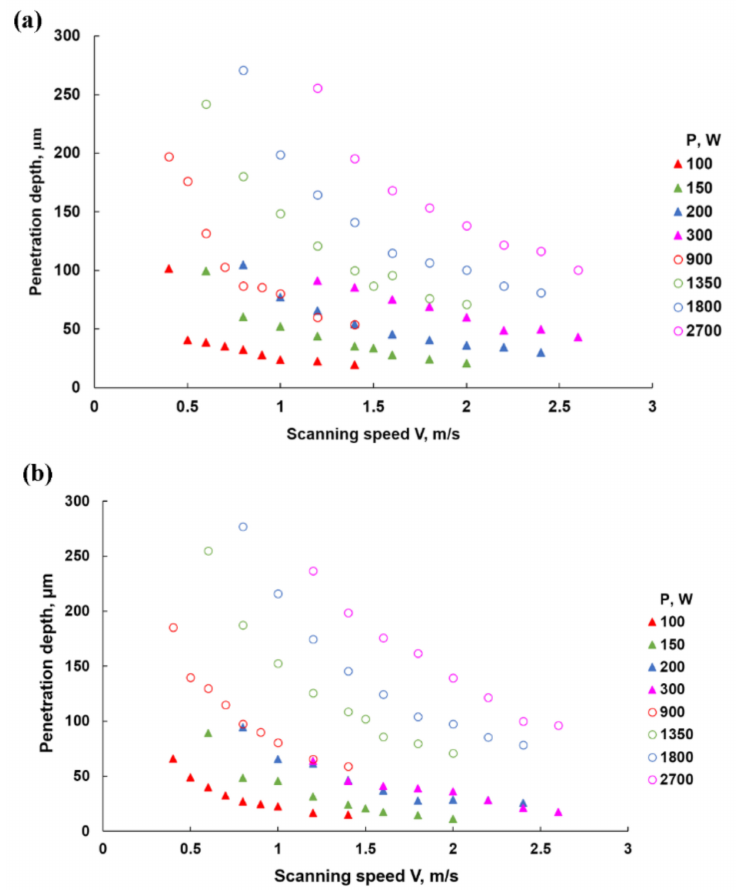
Figure 7. Penetration depth at different laser powers and scanning speeds with powder ( a ) and without powder ( b ). Table 2. Univariate analysis of variance, tests of between-subjects effects: the width of the track. Source Type III Sum of Squares Corrected